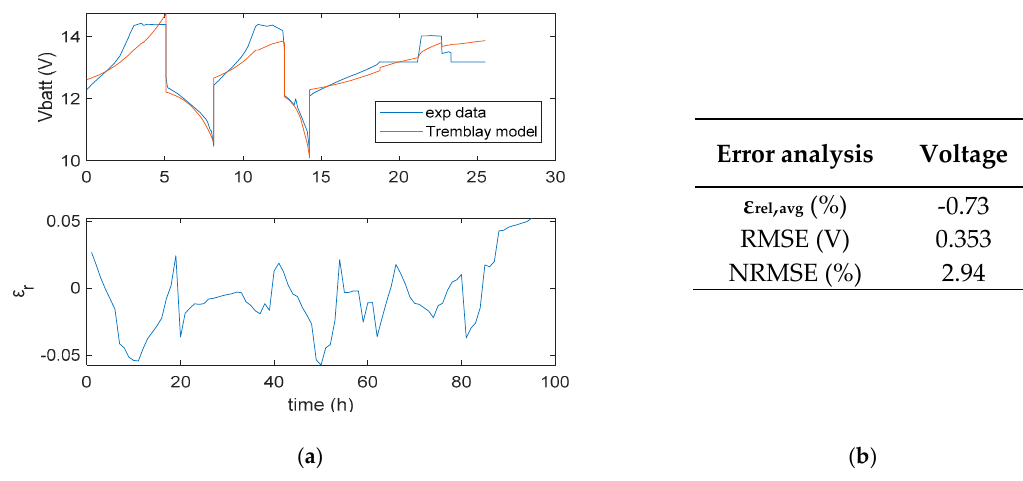
Figure 15. ( a ) Lead acid battery model validation; ( b ) error Figure 15. (a) Lead acid battery model validation; (b) error analysis.